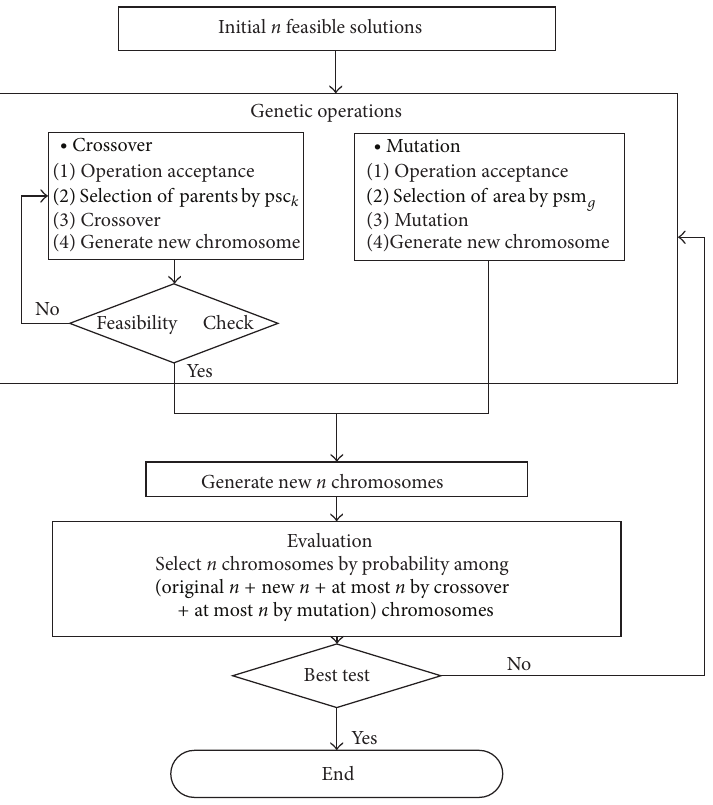
Figure 3: The procedure of a general approach that uses the separate feasibility check module.